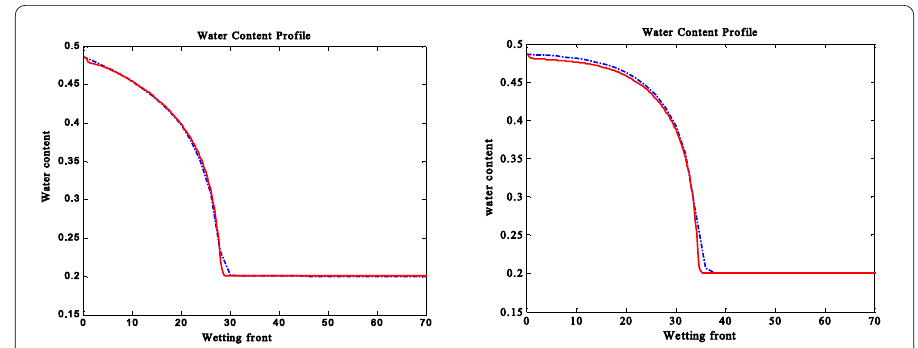
Figure 11 The comparison of this paper solution and simulation solution of Hydrus software at t = 500 min and (cid:11) t =